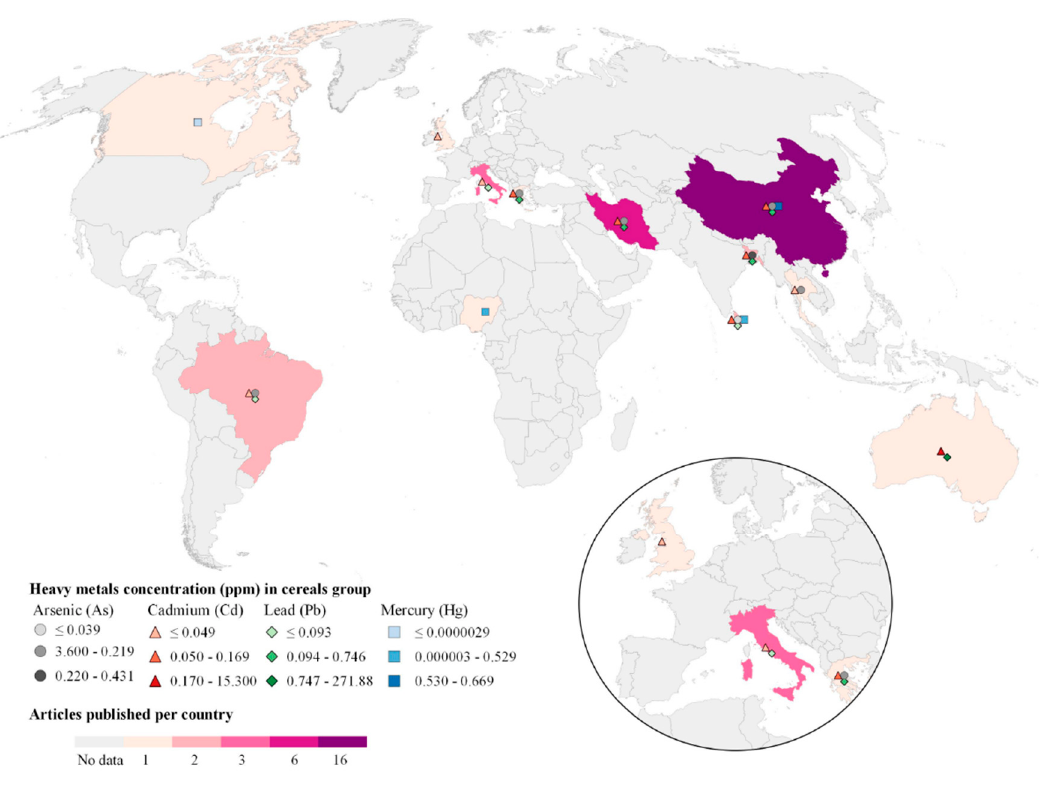
Figure 3. Heavy metals concentration in parts per million units in the most reported food groups worldwide. Source: Authors’ own elaboration. Data from the studies’ included in this Scoping Re- view Refs. [32–183].